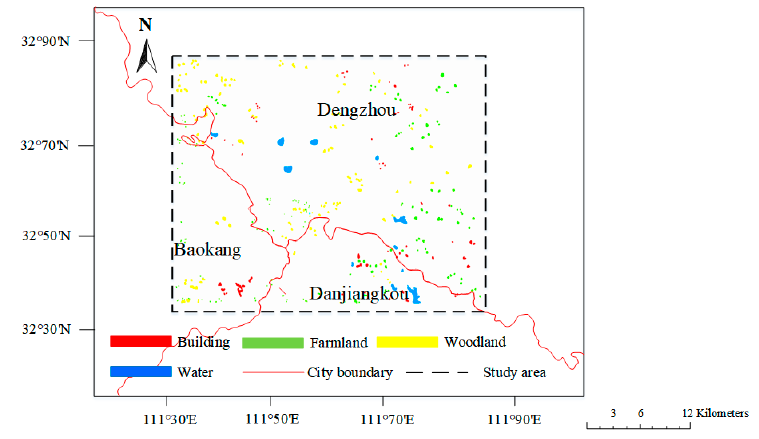
Figure 2. Distribution diagram of samples.